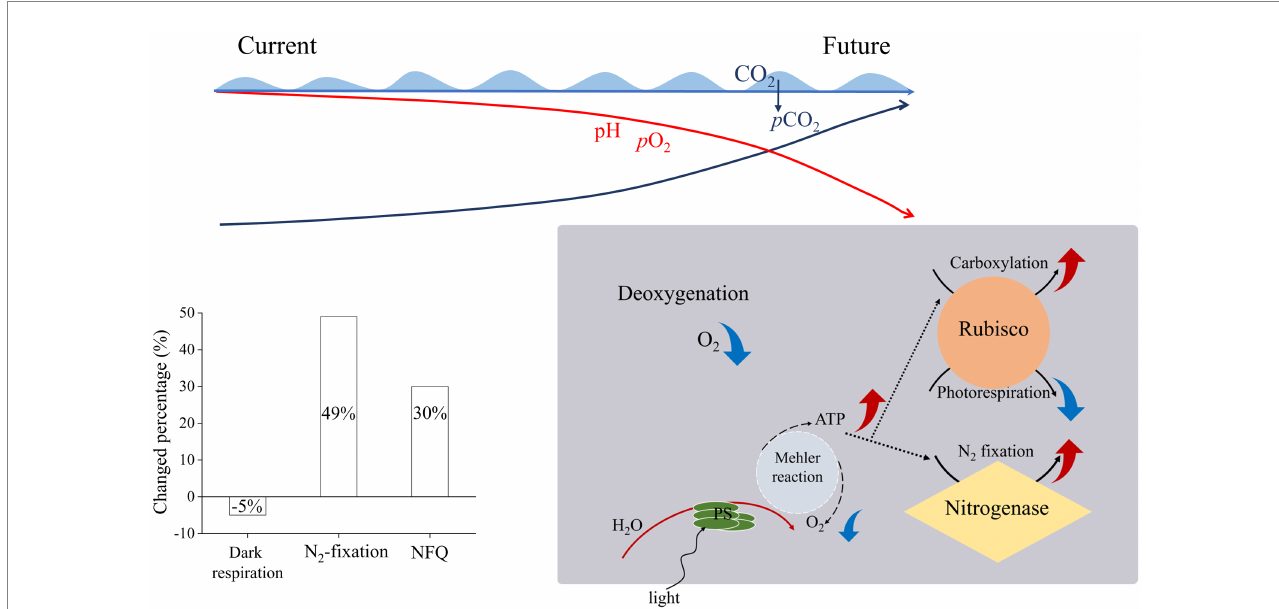
FIGURE 5 Illustration of the effects of ocean deoxygenation and acidification on Trichodesmium erythraeum , which is suggested to decrease its dark respiration by 5% and to increase its N 2 -fixation by 49% and N 2 -fixation quotient (NFQ, ratios of N 2 fixed per C fixed) by 30% with 16% decline of p O 2 and 138% rise of p CO 2 by the end of this century.